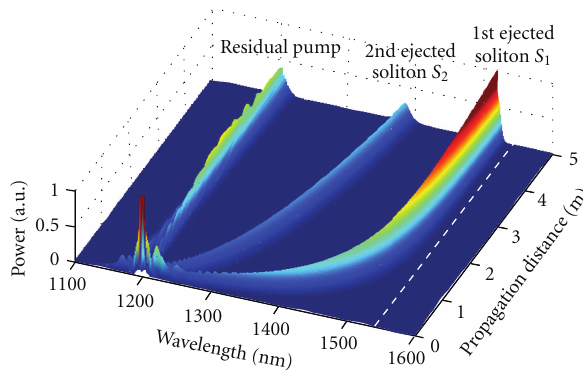
Figure 6: Numerical simulation of the propagation of a 270 fs Gaussian pulse with 15 kW peak power centered at 1200 nm, showing fission and ejection of two fundamental solitons S 1 and S 2 . All frequency-dependant parameters of the fiber were taken into account. The white dashed line represents the PBG